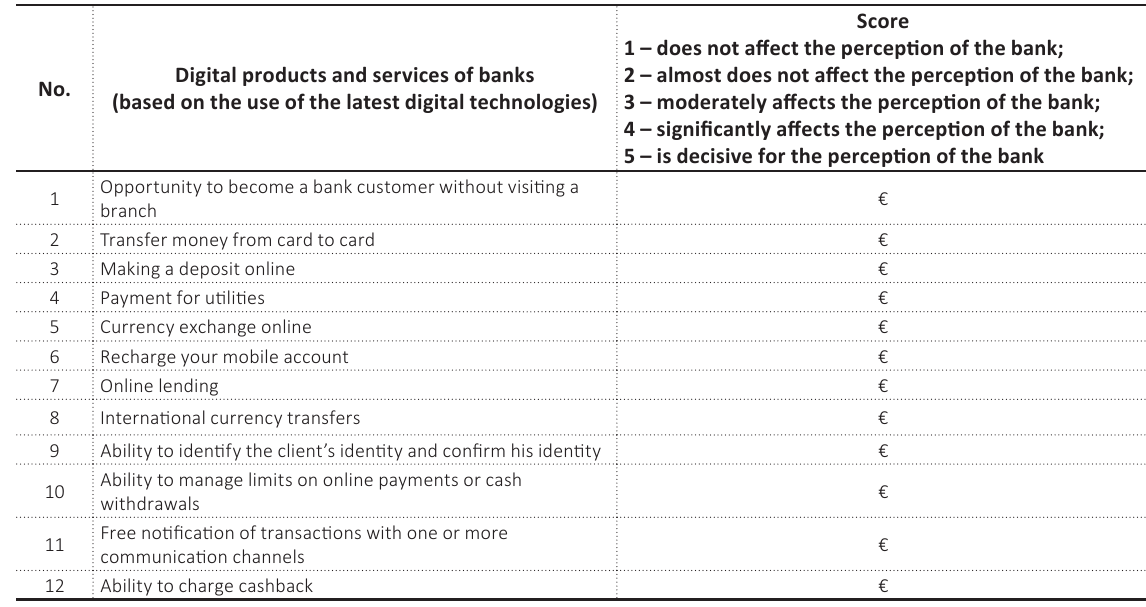
Table A1. Questionnaire form for surveying respondents to assess the impact of effective interaction between a bank and customers concerning specific digital products and services of banks in Ukraine and